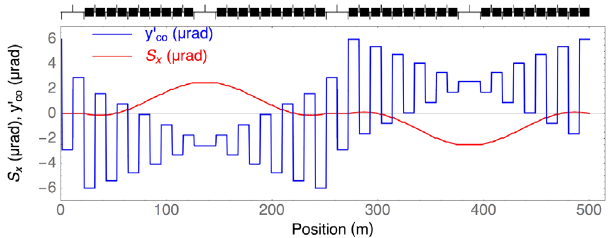
FIG. 5. Radial spin and slope of vertical closed orbit with closed orbits shown in Fig. 4 due to misaligned quadrupoles.